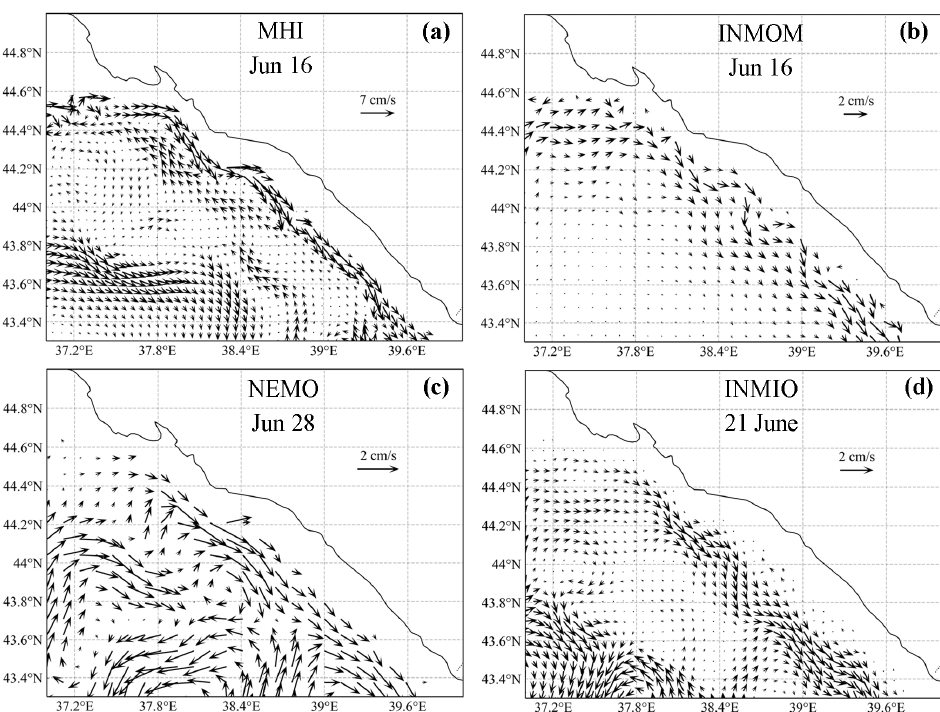
Figure 4. Current velocity field in June 2011 according to ( a ) the MHI simulation at the horizon of 1100 m, ( b ) the INMOM simulation at the horizon of 900 m, ( c ) the NEMO simulation at the horizon of 1000 m, and ( d ) the INMIO simulation at the horizon of 900